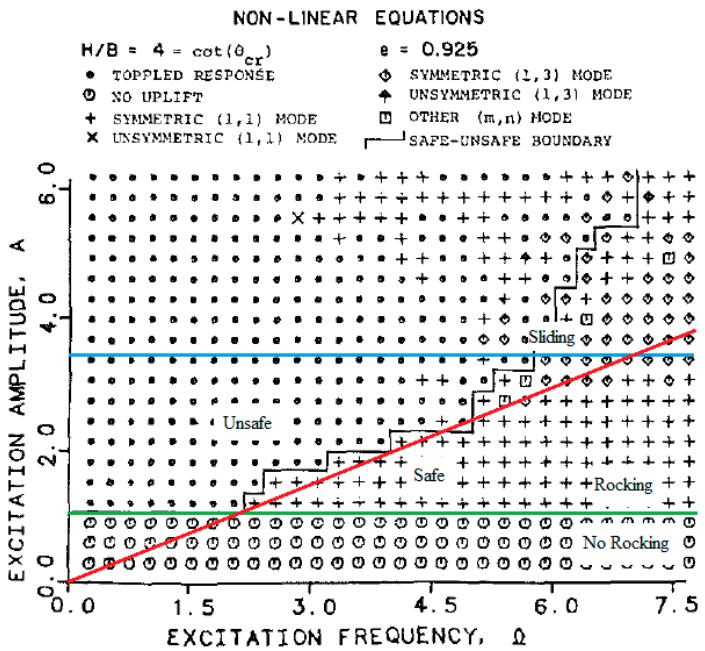
Figure 9. Safe–unsafe boundary for half sine impulse drawn on top of the overturning acceleration spectrum of the freestanding rocking block with tan α = 0.25 under a harmonic acceleration forcing function after Figure 4 of Spanos and Koh [8] (permission requested).